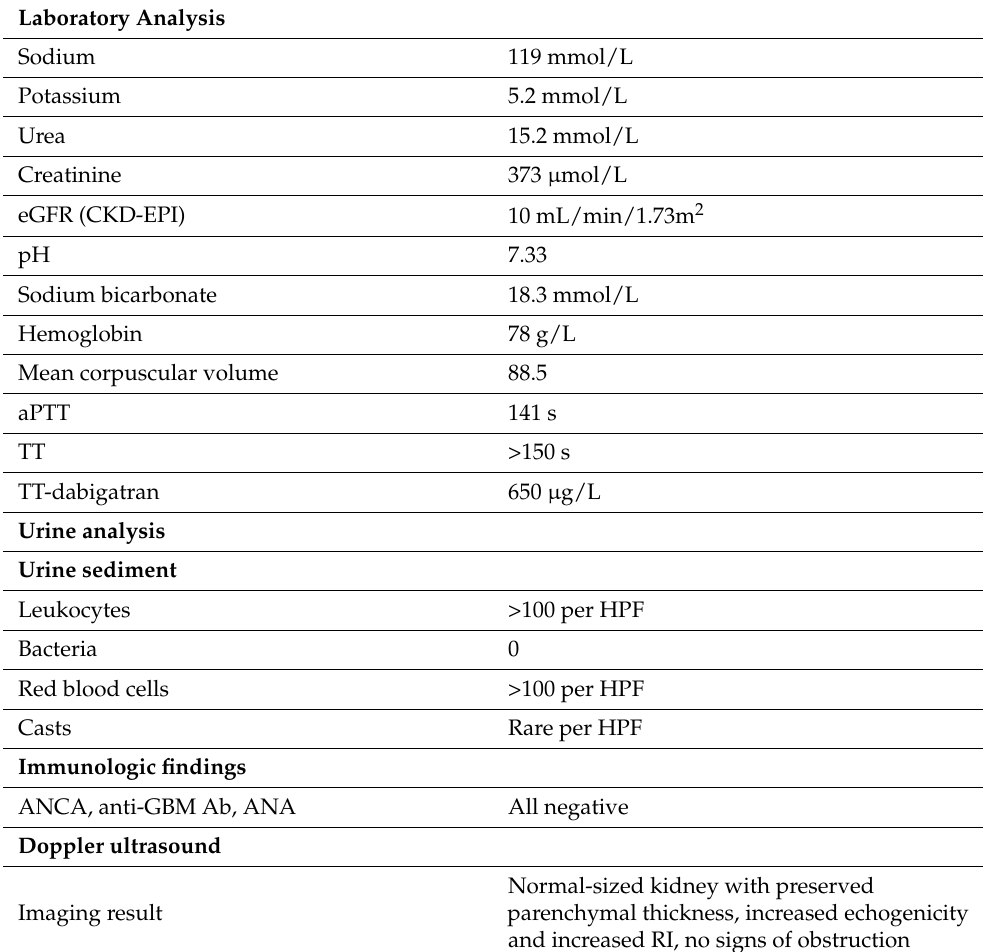
Table 1. Laboratory and ultrasonography findings in the presented patient on